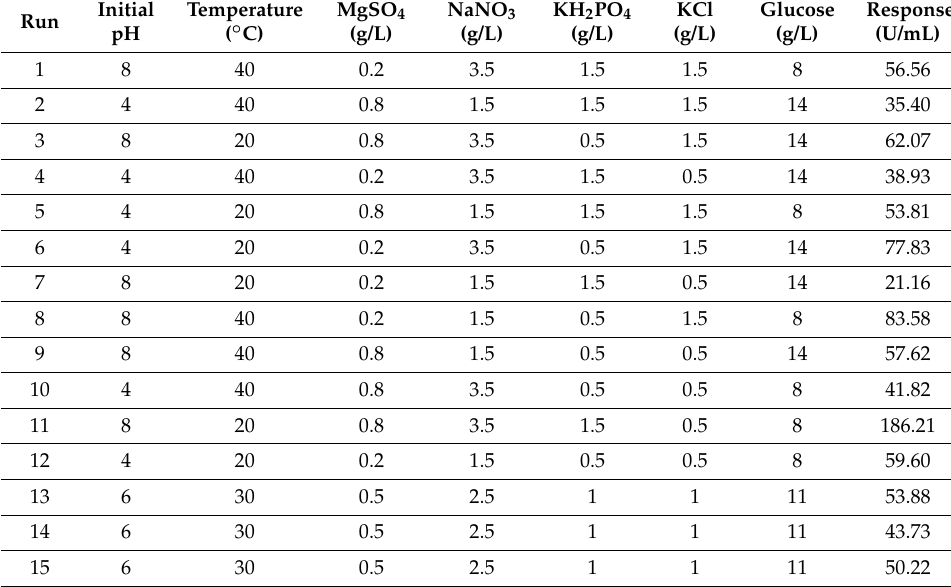
Table 1. Plackett-Burman design for screening of significant factors affecting the protease production by Penicillium bilaiae .